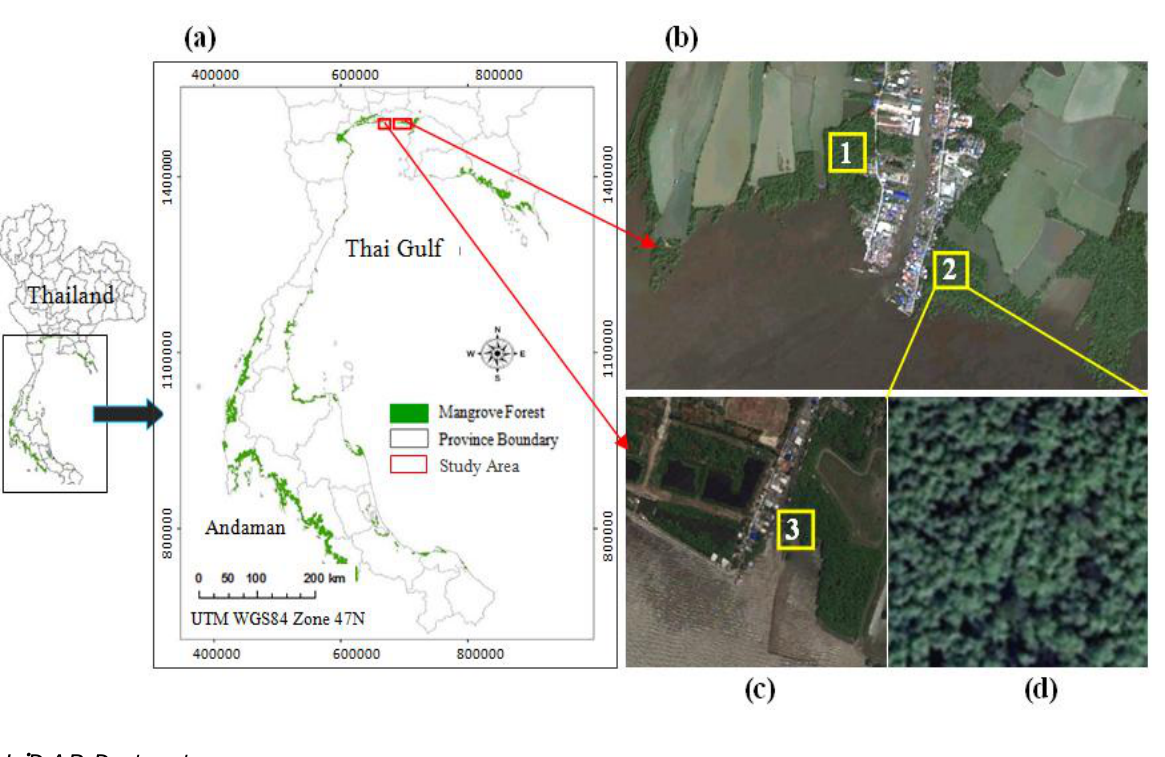
Figure 1. The location of the study sites in Samut-Prakan Province: ( a ) mangrove distributions along the coast of Thailand; ( b ) and ( c ) locations of the experimental plots; and ( d ) the mangrove canopy in the study plot from an IKONOS